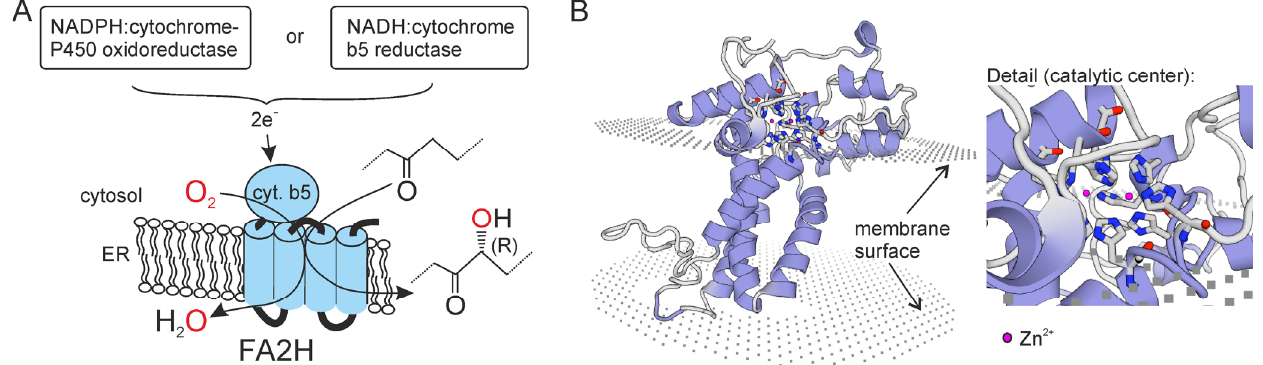
Figure 2. Enzymatic reaction catalyzed by FA2H and structure of the enzyme. ( A ) Reaction scheme of the 2-hydroxylation reaction of FA2H. ( B ) Model of the human FA2H enzyme (without cytochrome b5-like domain). Molecular modeling of human FA2H (Ac. Q7L5A8) was performed using Swiss Model (https://swissmodel.expasy.org/; accessed on 14 January 2023) with yeast FA2H (SCS7p; PDB file AZR0) as template. The histidine residues and the two zinc ions forming the catalytic center of the hydroxylase domain of the enzyme are highlighted and shown in the enlarged section on the right.